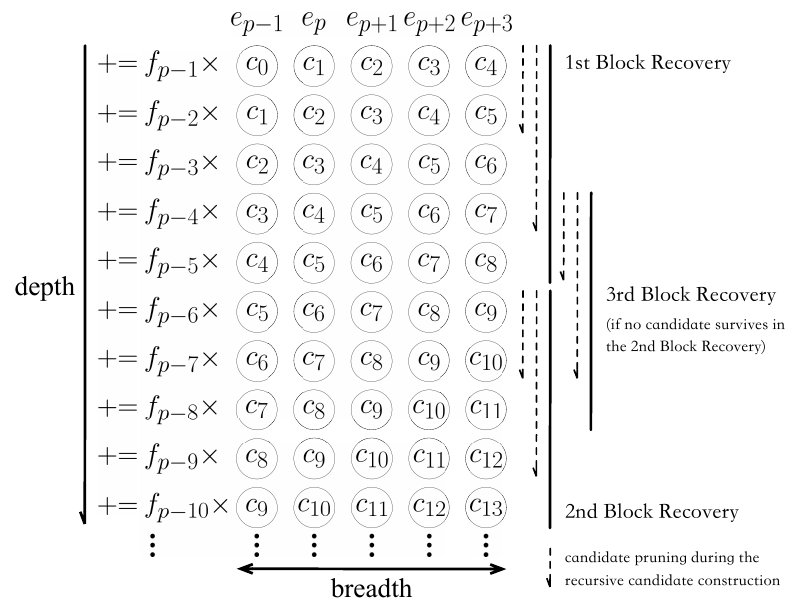
Figure 2: The HIDCPA with m = 5, n = 2, and l =